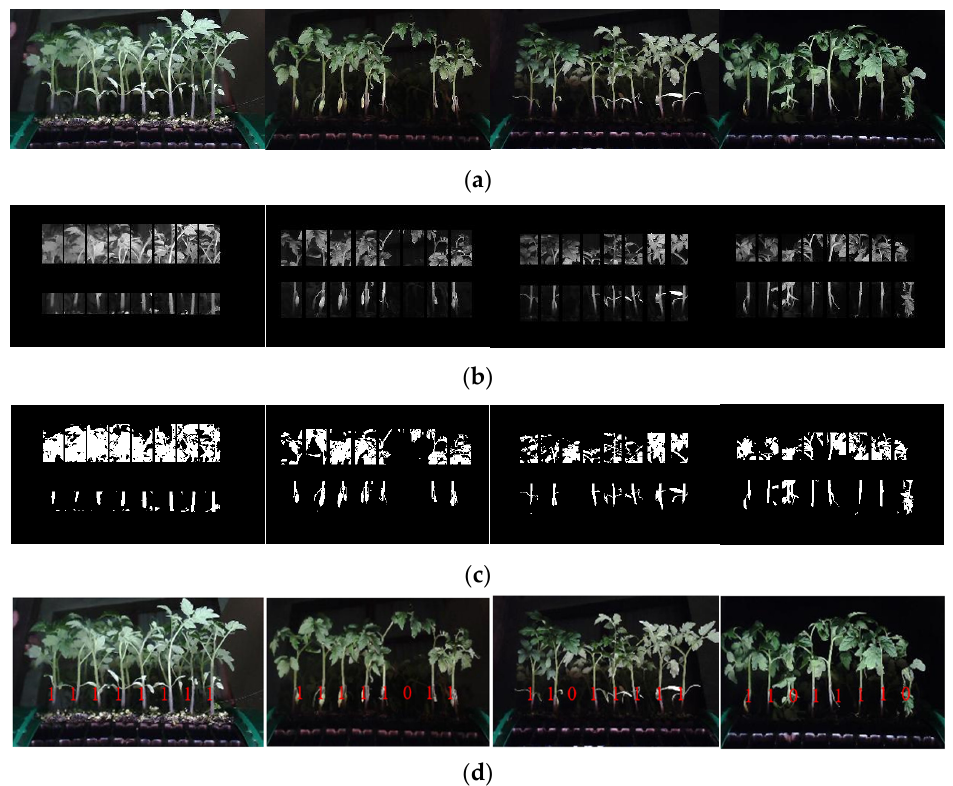
Figure 9. Segmentation and identification of seedling. ( a ) Original image; ( b ) mask image; ( c ) sample